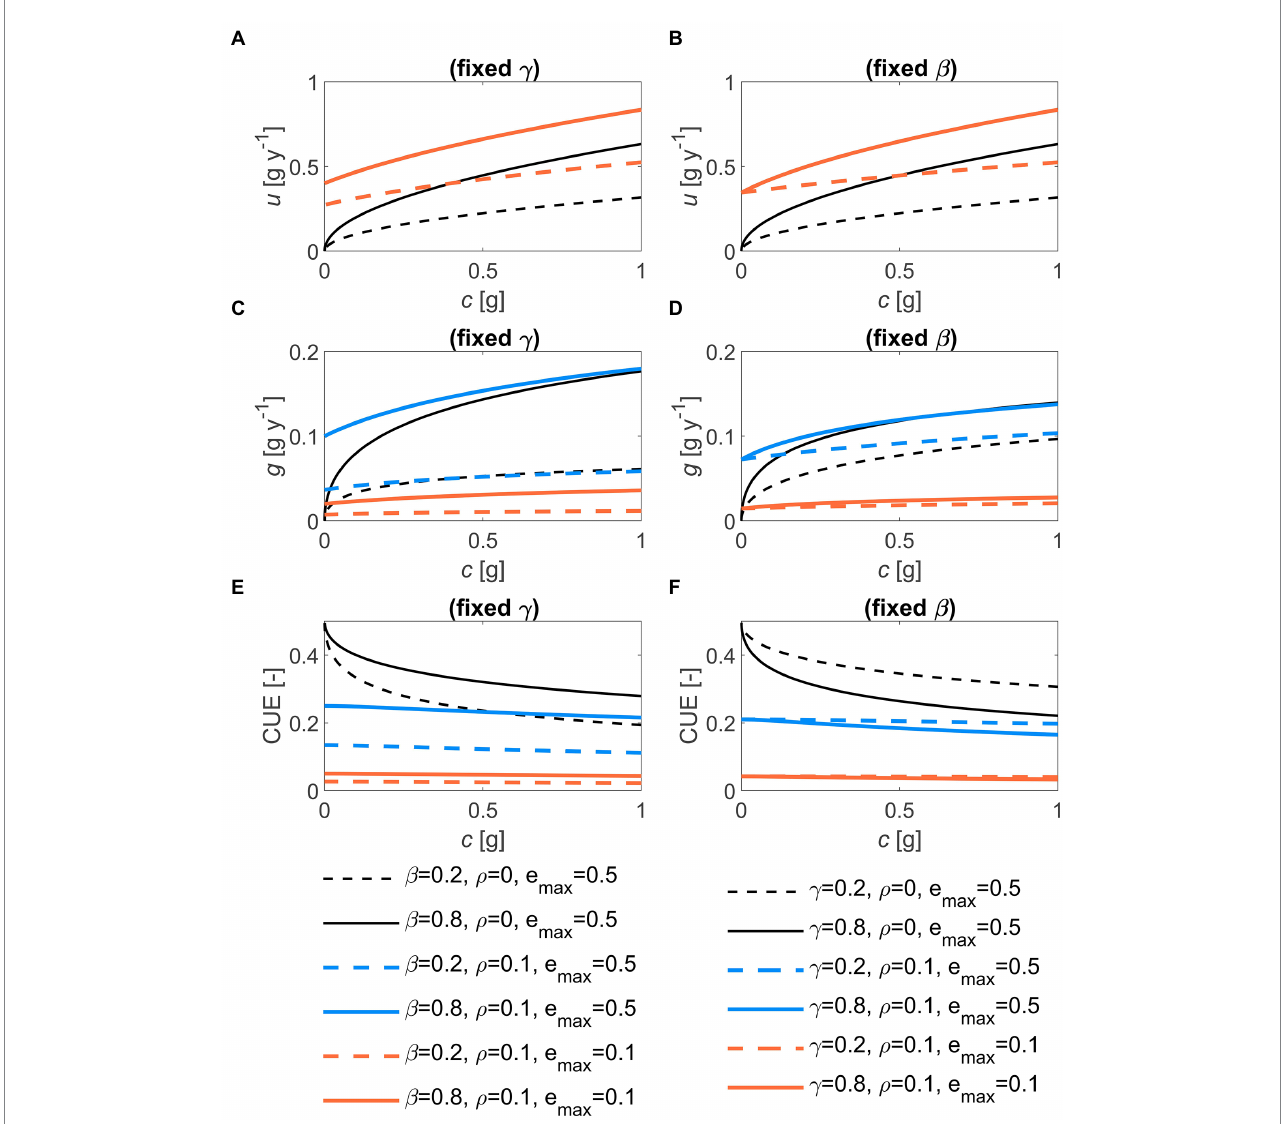
FIGURE 3 Effects of the half saturation constant of the microbial growth rate ( b , left panels) and of the first-order decay constant ( g , right panels), for two values of maintenance respiration ( r ) and maximum growth efficiency ( max e ) on: (A,B) the relation between optimal decomposition rate and substrate carbon, u ( c ); (C,D) the relation between optimal growth rate and c , g ( c ); and (E,F) the relation between microbial C-use efficiency (CUE) and c . In all panels: 0 c = 1 g, m= 0.5. Parameter units are as in Table